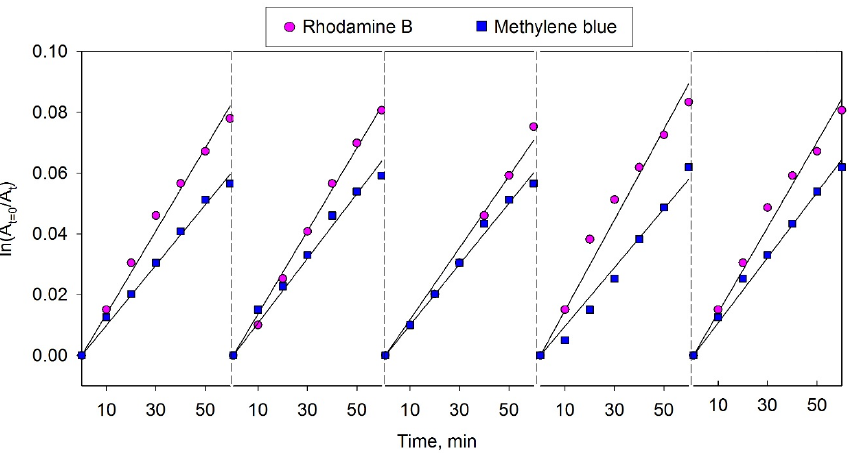
Figure 8. Degradation kinetics of MB and RhB during 5 cycles of dye photodegradation using sample BMO3 under visible light irradiation.